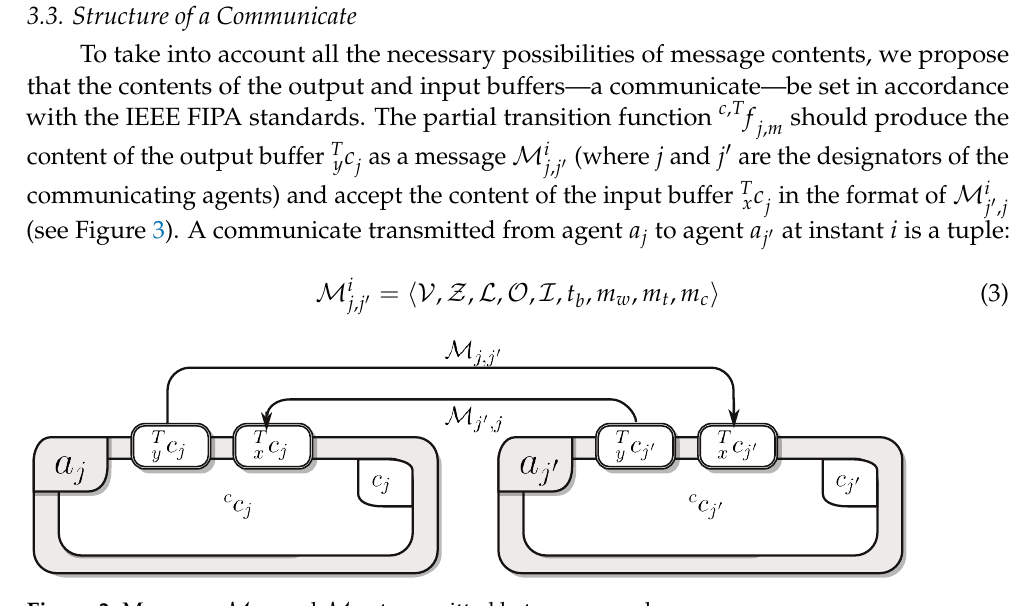
Figure 3. Messages